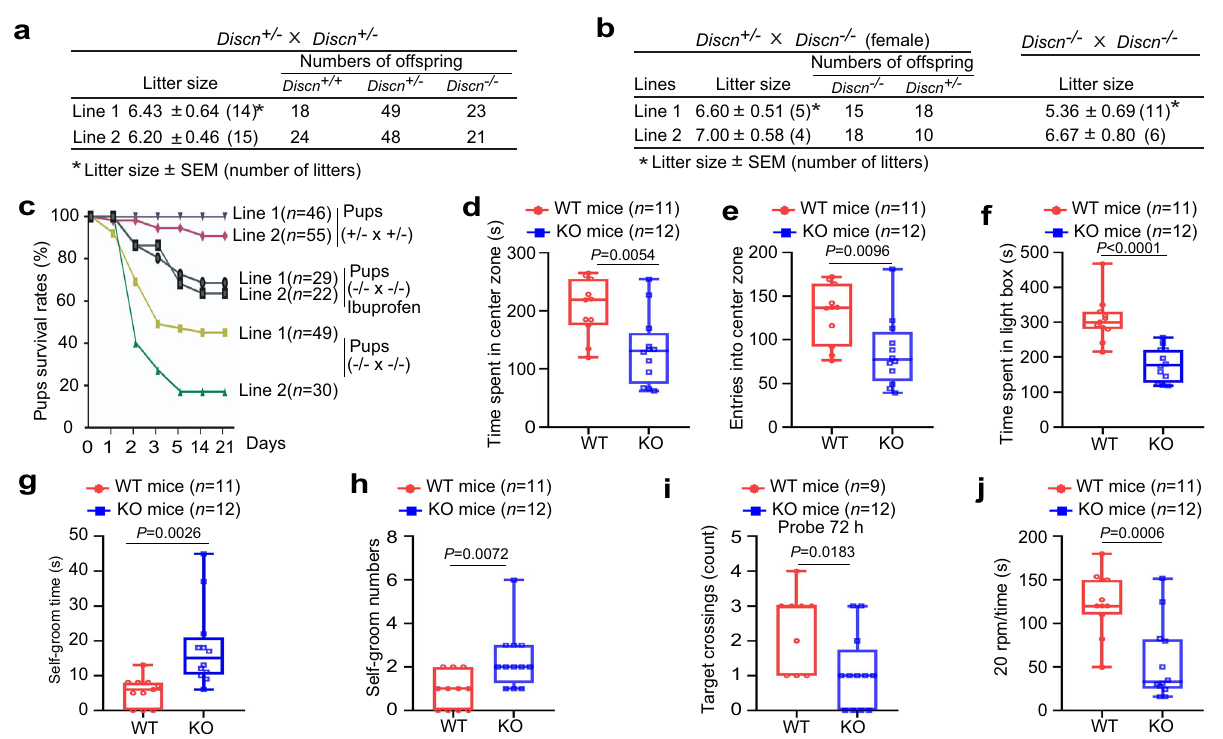
Fig. 6 Discn knockout (KO) causes newborn death and compromises brain functions in survived adults. a Discn + / − crossing generated pups with normal Mendelian ratios. b Discn − / − females mated with Discn + / − or Discn − / − males had normal litter sizes and Mendelian ratios. c Survival curve of offsprings from different mating strategies. Note that Discn − / − pups from Discn − / − crossings displayed newborn death, and administration of ibuprofen (0.4 mg/mL) to pregnant females alleviated the neonate death. Adult Discn − / − mice and their WT littermates from Discn + / − crossings were utilized for behavioral tests. In open fi eld test, Discn − / − mice spent less time in the center zone ( d ) and entered fewer times into the center zone ( e ) compared to the WT littermates. In light – dark box test, Discn − / − mice stayed in the light box for less time than WT littermates ( f ). In self-grooming behavior analysis, Discn − / − mice spent longer time ( g ) and showed more bouts ( h ) on self-grooming when compared to WT littermates. In Morris water maze test, at 72 h after 7-day probe trials, Discn − / − mice showed fewer platform crossings than WT littermates ( i ). In rotarod test, Discn − / − mice stayed on the rotating rod for shorter time than WT littermates ( j ). Data were representative of individual values with box and whiskers plots showing the median, upper and lower quartiles, and minimum and maximum in ( d – j ). Statistical differences were determined using two-tailed Student ’ s t and balance abilities. Discn − / − mice stayed on the rotating rod higher level of DNA DSBs measured by γ H2AX staining and without falling for shorter time than WT littermates when the speed neutral comet assay (Fig. 7a, b), and cytosolic dsDNA (Fig. 7c) reached 20 rpm (Fig. 6j), indicating the reduced coordination and compared to WT pups. Notably, KO pups from Discn − / − crossings had more abundant DSBs and cytosolic dsDNA than balance. Because Discn − / − neonates generated from Discn − / − crossings displayed more severe phenotype than those generated those from Discn + / − crossings (Fig. 7b, c). Similar results were from Discn + / − crossings, we suspected that Discn − / − adults from Discn − / − crossings could have worse brain functions. To test this hypothesis, we compared their coordination and balance abilities.